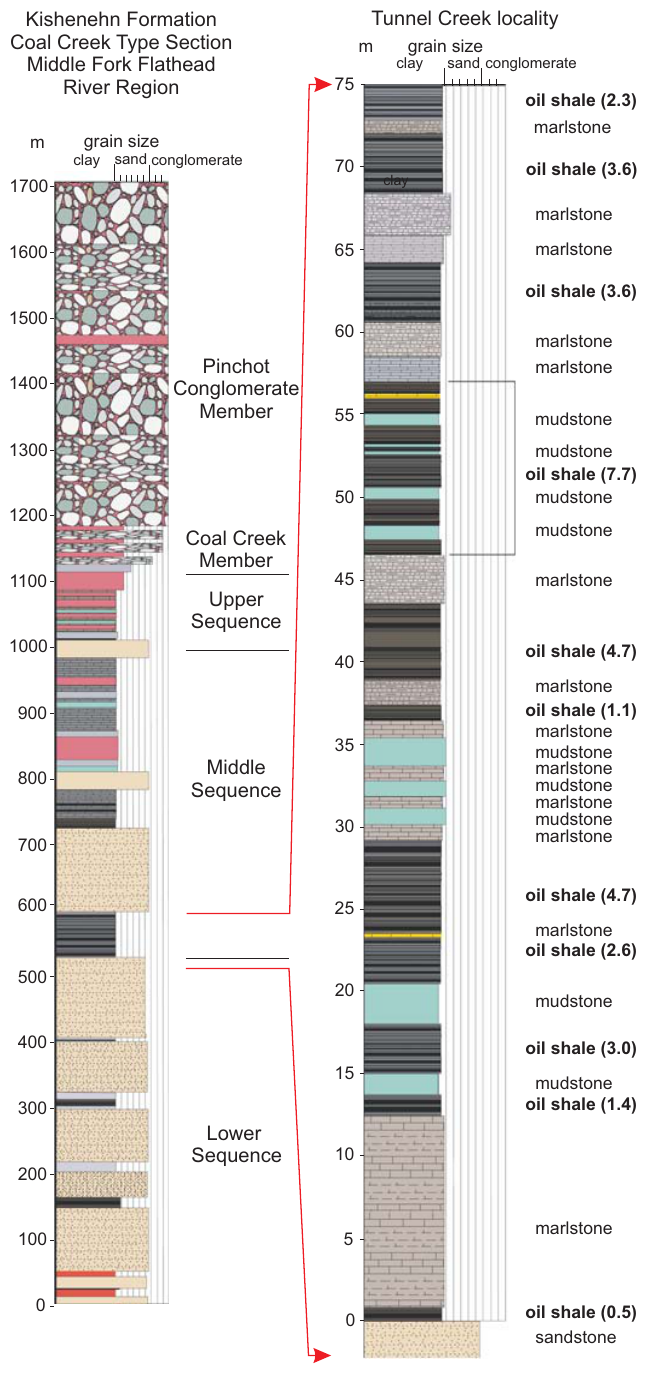
Fig. 1. Stratigraphy of the middle Eocene Kishenehn Formation from the type area at Coal Creek, Middle Fork of Flathead River region, shown in relation to the measured section at the Tunnel Creek locality—oil shale stra- tigraphy is representative of the other insect localities and demonstrates the heterogeneous lithologic makeup of the lower sequence of the Coal Creek Member. The thicknesses of the oil shale beds in meters is shown in paren- theses. For the interval with numerous interbeds of marlstone and mudstone denoted by the bracket, the composite thickness of oil shale is listed. The oil shale within this bracket contains fossil